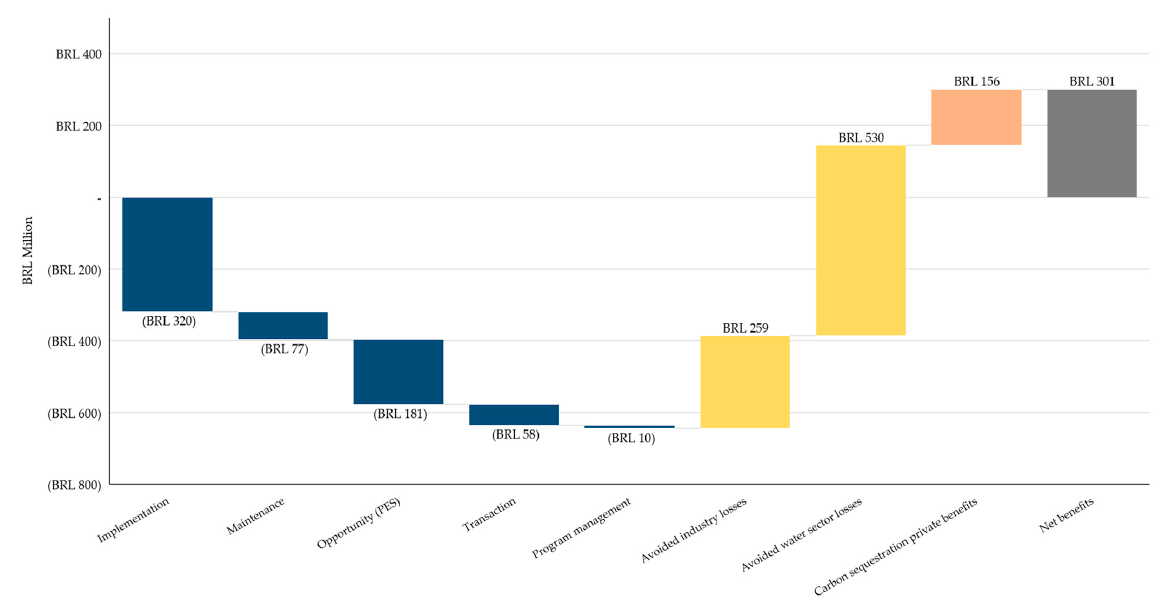
Figure 7. Full lifecycle (35-year) NPV if only the water supply to the industrial and water sectors is counted as benefits (Scenario 1) . Colors indicate costs (blue bars), benefits (yellow bars), and net benefits (grey bar).